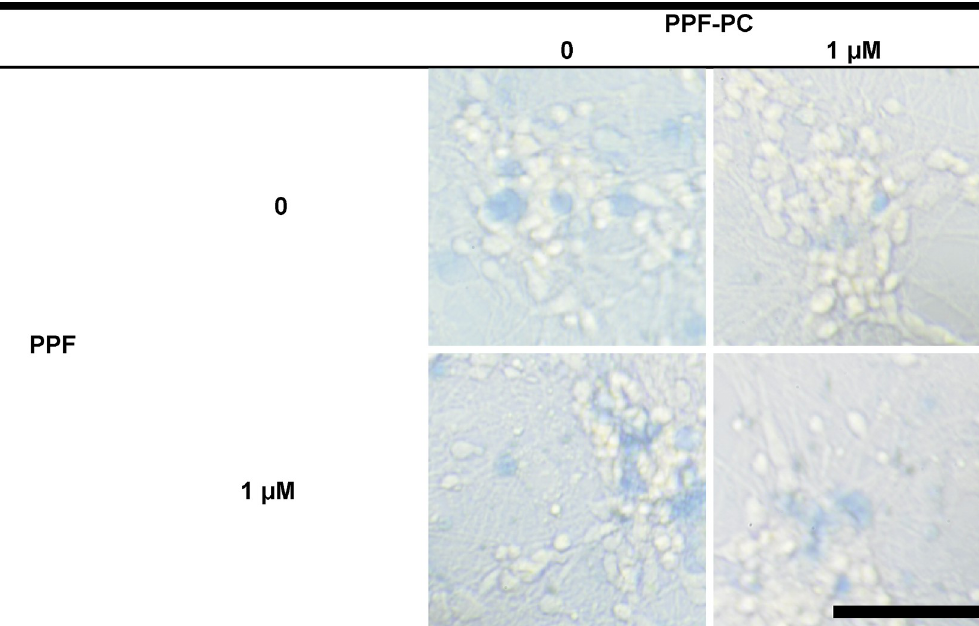
Fig 6. Transmitted light microphotographs of primary cultured cortical neurons exposed to vehicle (DMSO in PBS) or 100 μ M PPF on DIV 3, taken 24 h after the exposure. Regardless of PPF-PC on DIV 2, PPF exposure on DIV 3 significantly induced neuronal death compared to vehicle. Scale Bar = 100 μ m.